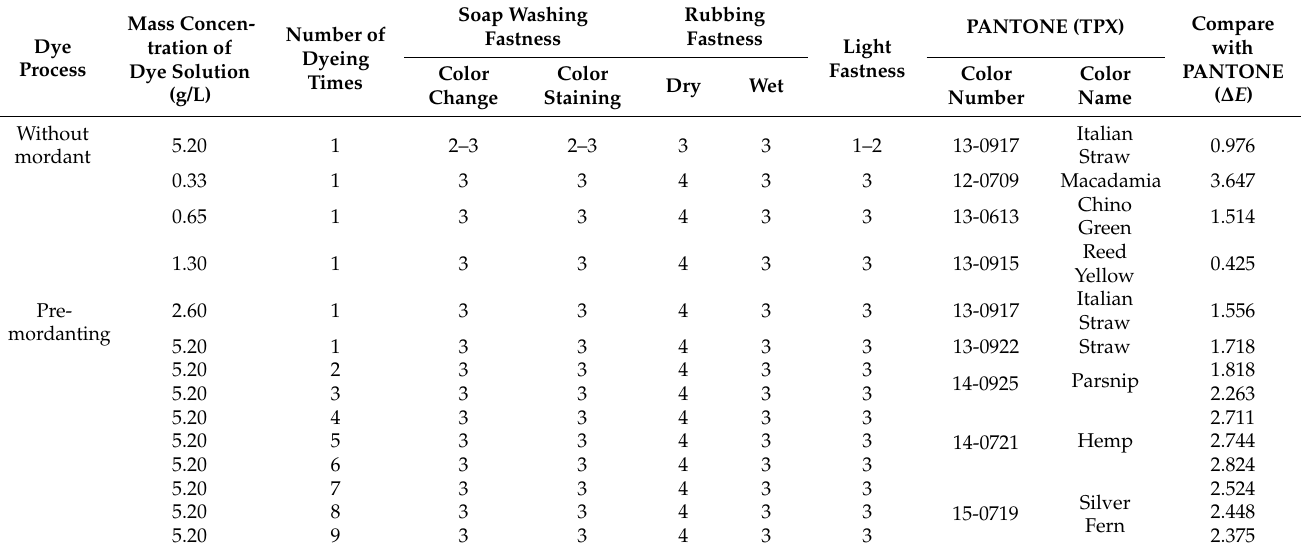
Table 1. Color fastness and color evaluation of dyed cotton